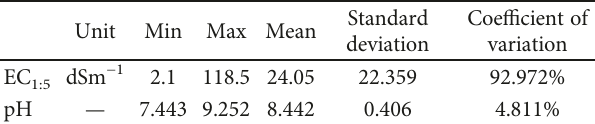
and pH of soil 1:5